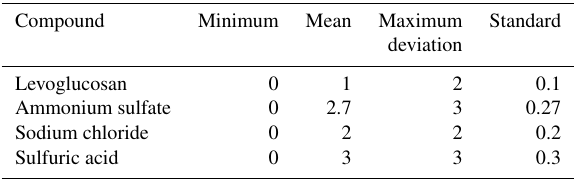
Table 2. Parameters of the normal distributions from which the van ’t Hoff factors are sampled; the standard deviations are chosen to be 10% of the mean. Randomly sampled values that lie outside of the range of the minimum and maximum are